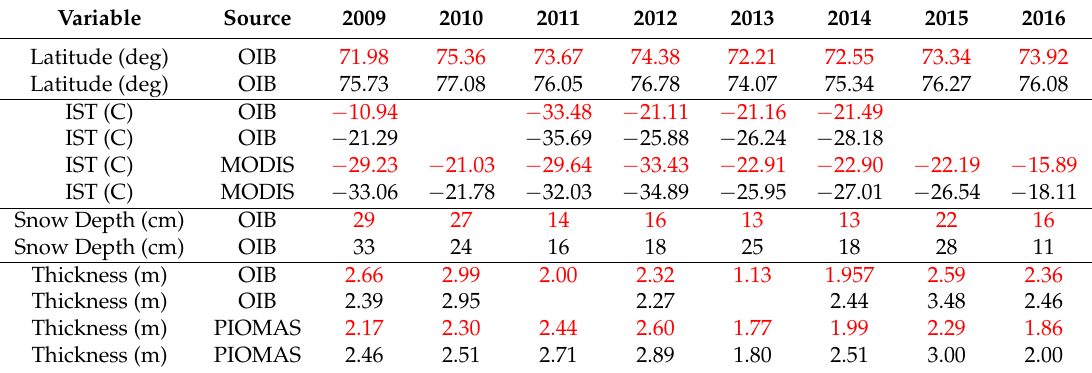
Table 4. Mean Operation IceBridge and satellite derived spring surface conditions of melted ( red ) and surviving ( black ) ice